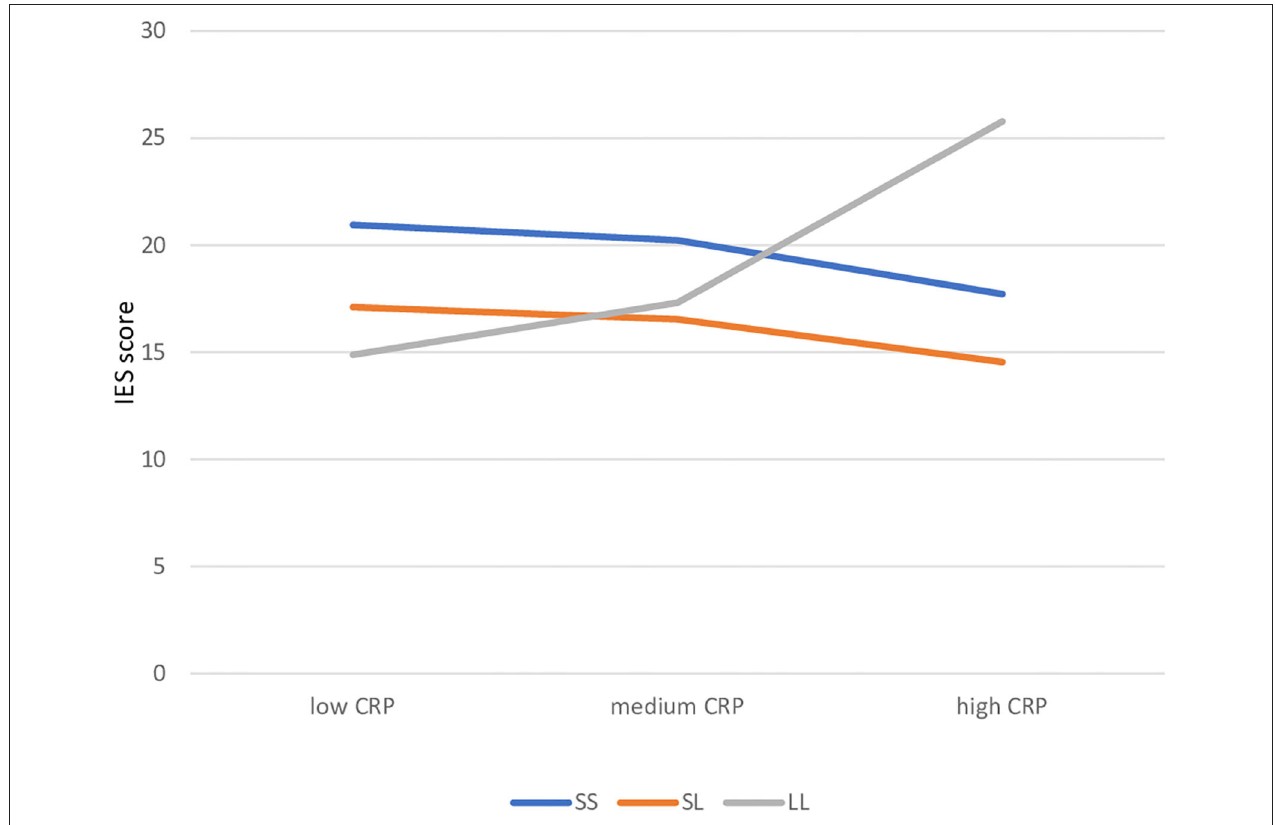
FIGURE 1 | Gene-environment interaction: simple slopes of cancer-related problems in predicting IES score by 5HTTLR genotype. CRP, Cancer Related